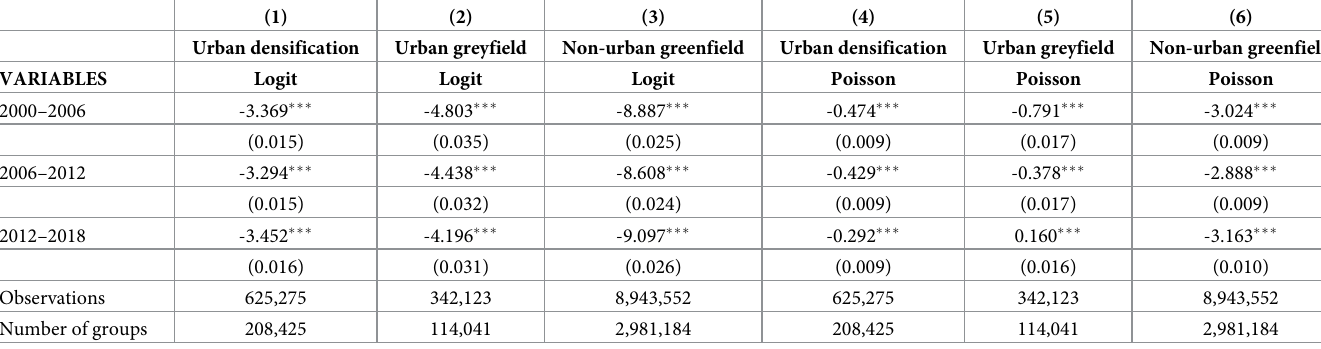
Table 3. Regression results for the three main development processes, for the periods